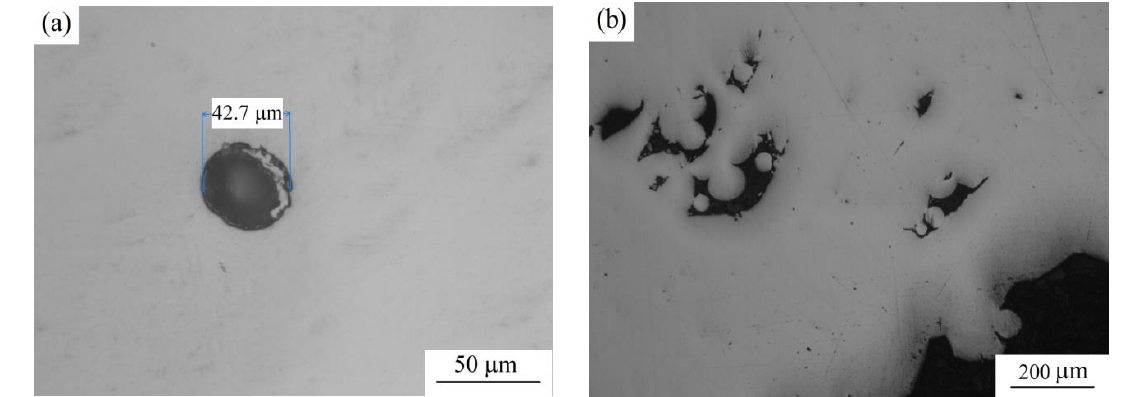
Figure 4. Pores on the thin sections: ( a ) For detail No. 4; ( b ) For area of joining of the substrate and the weld part on the sample of detail No. 5.